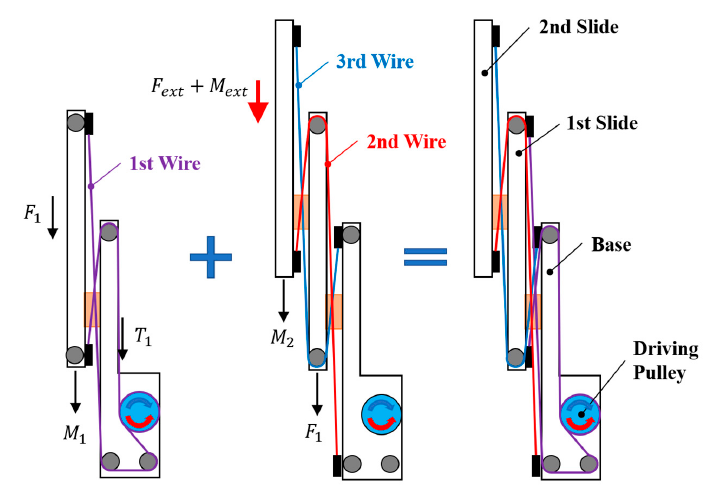
Figure 4. Free body diagram of the bidirectional telescopic mechanism.